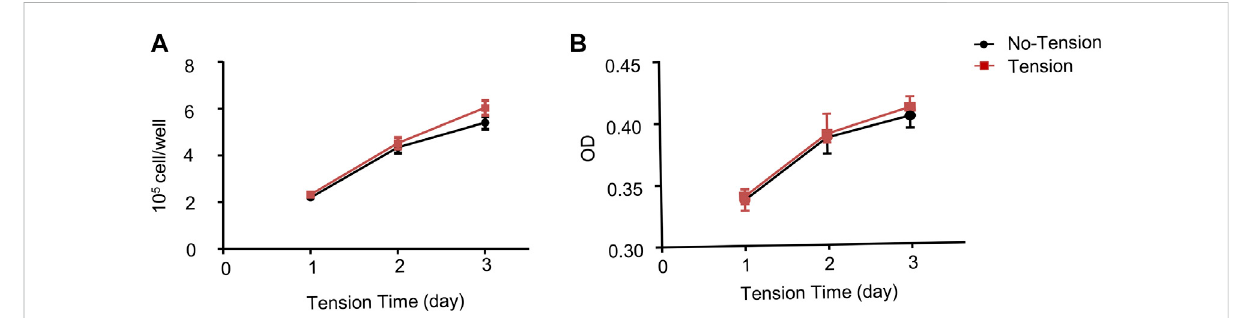
FIGURE 2 Effect of mechanical tension on proliferation of hASCs. (A) hASCs were cultured in growth medium for 1-, 3-, or 5-day with or without tension. The number of surviving cells was calculated (B) Proliferation ability of hASCSs was measured by Cell Counting Kit-8 (CCK8) assays. Values are